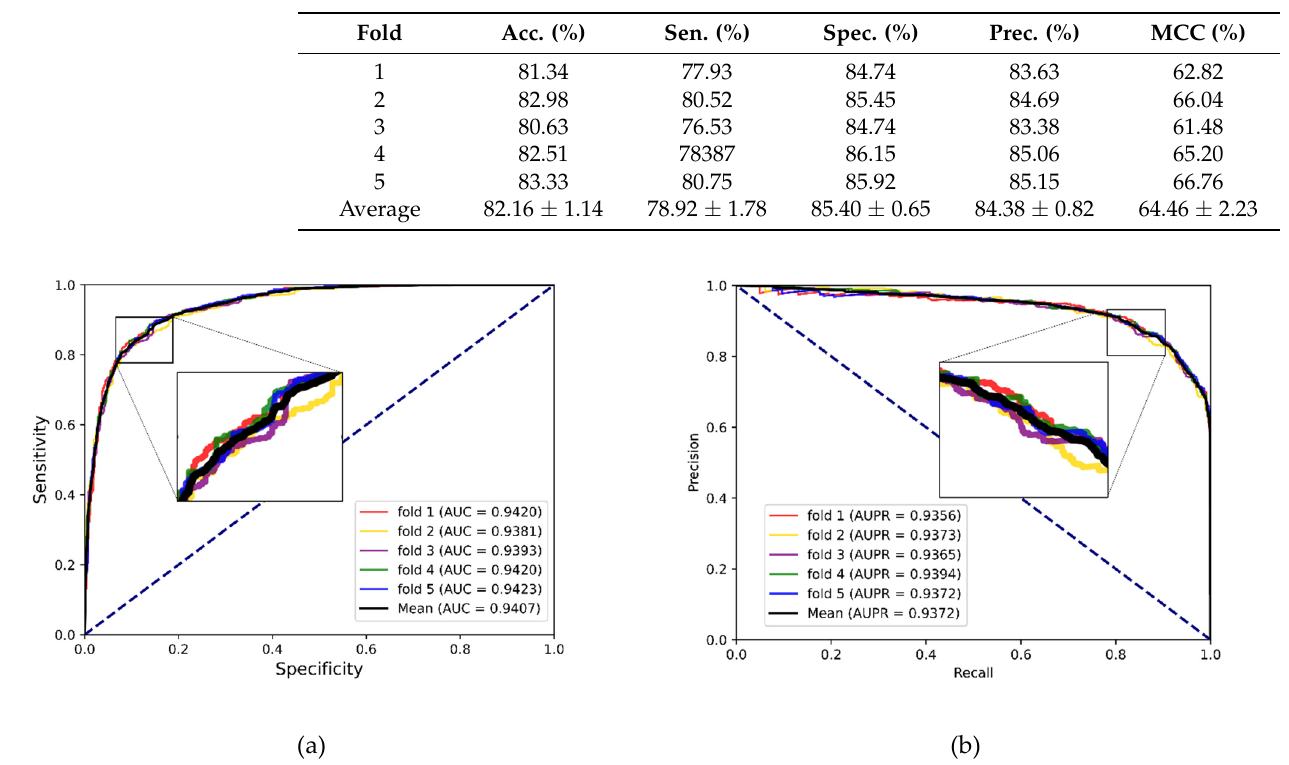
Figure 4. ( a ) The ROC curves of the result on the ncDR datasets. ( b ) The PR curves of the result on Figure 4. (a)The ROC curves of the result on the ncDR datasets. (b) The PR curves of the result on the ncDR datasets. the ncDR datasets.